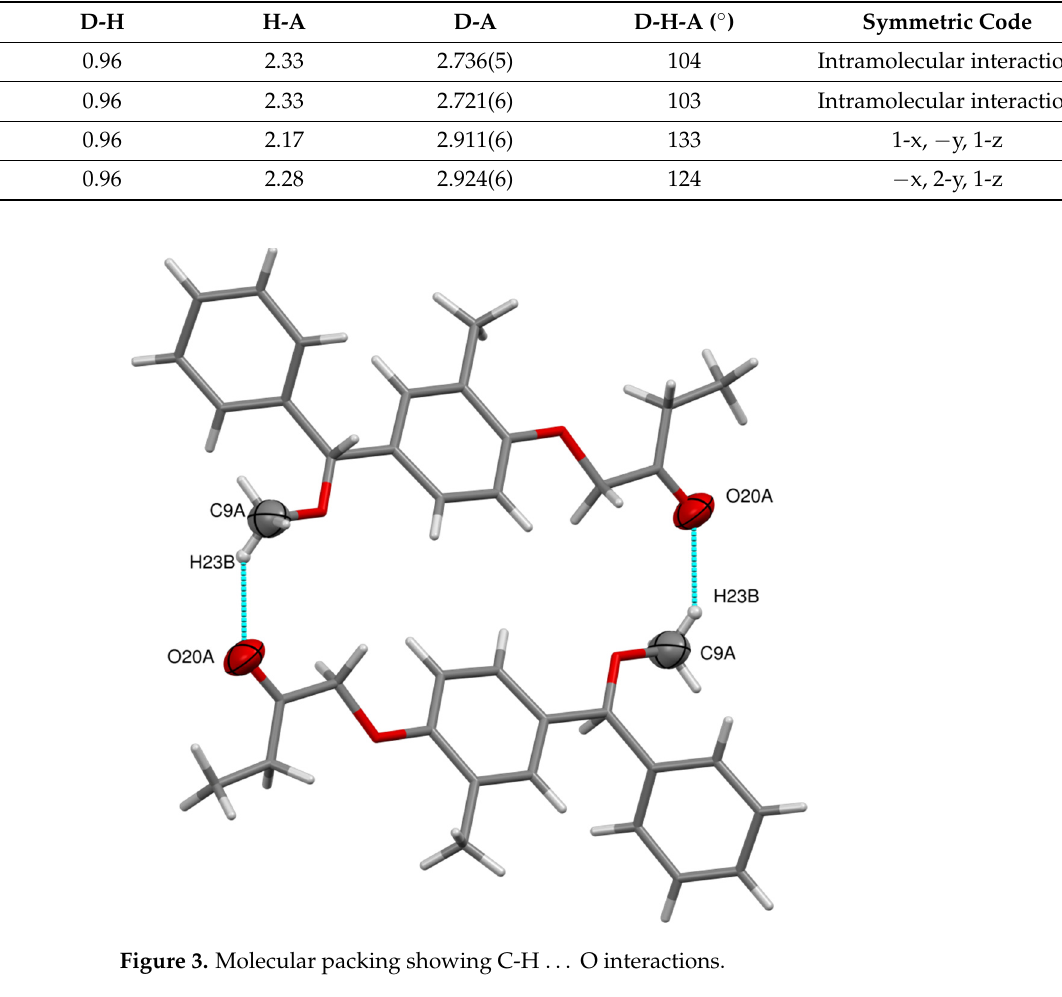
Table 2 . Hydrogen bond geometry(Å). D-H-A